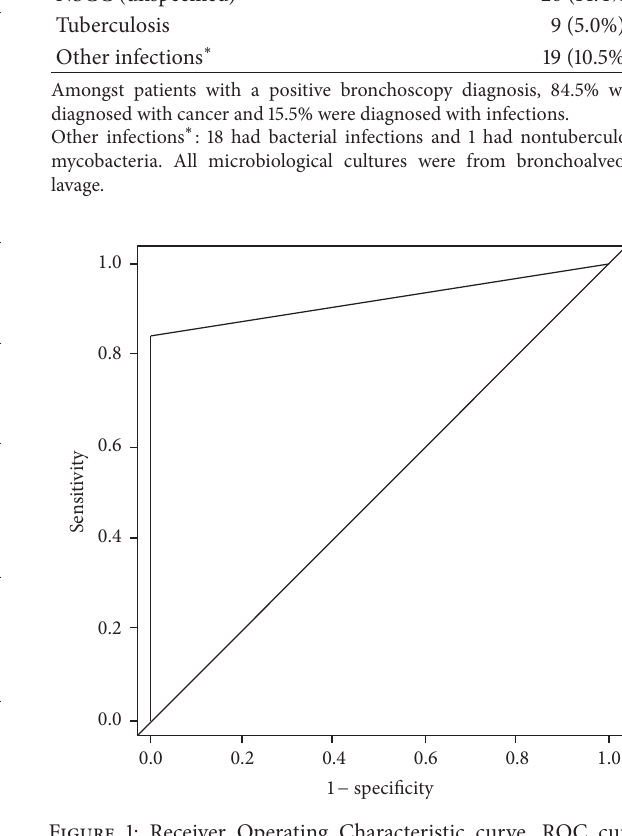
Figure 1: Receiver Operating Characteristic curve. ROC curve when using bronchoscopic to predict cancer and infection. Sensi- tivity 84.2% and specificity